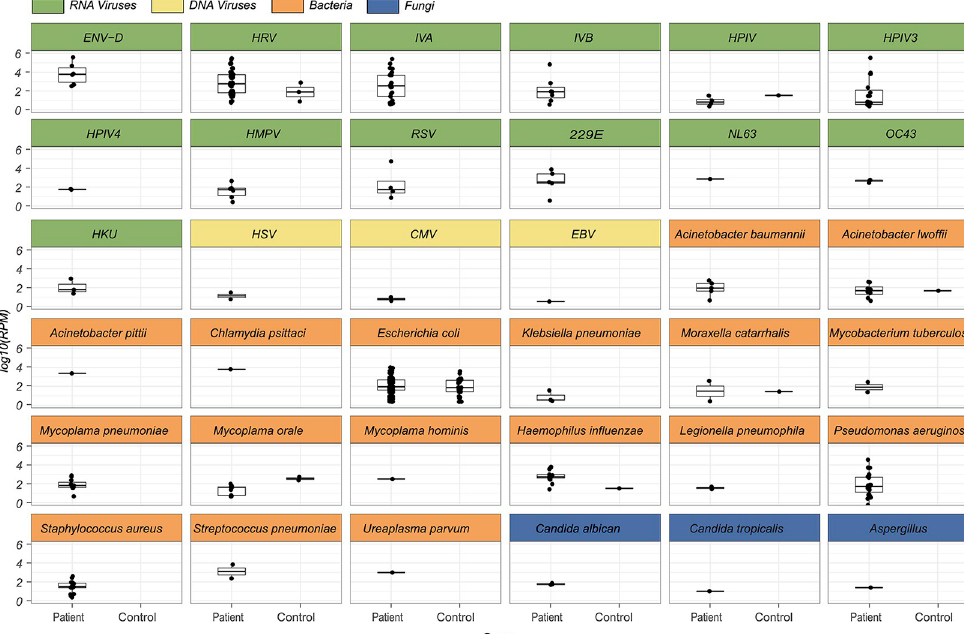
Fig 5. Comparison of prevalence levels between the healthy and control groups. Boxplots for patient and control groups for each pathogen identified in this study, including RNA virus (green), DNA virus (yellow), bacteria (orange) and fungus (blue). For clarity, only non-zero abundance levels are